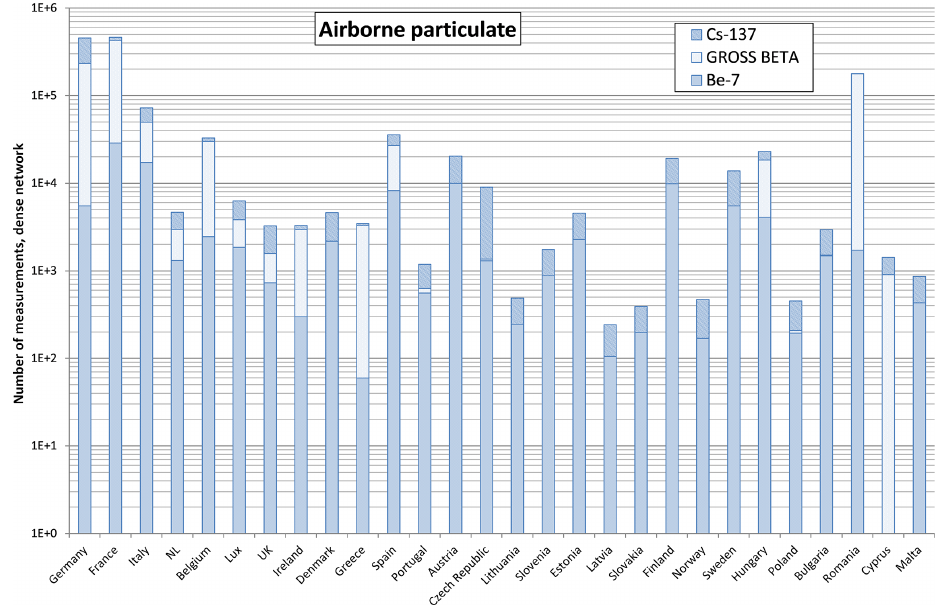
Figure 8. Total number of measurements in REMdb (dense network) for sample type airborne particulates, 137 Cs, total beta and 7 Be, by country as recommended in